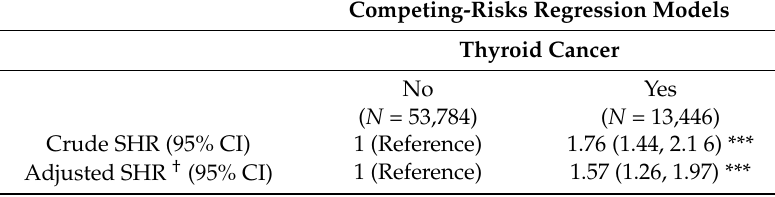
Table 4. Incidence and subhazard ratio (SHR) of macular degeneration in patients with thyroid cancer compared to those without thyroid cancer using the competing-risks regression models.